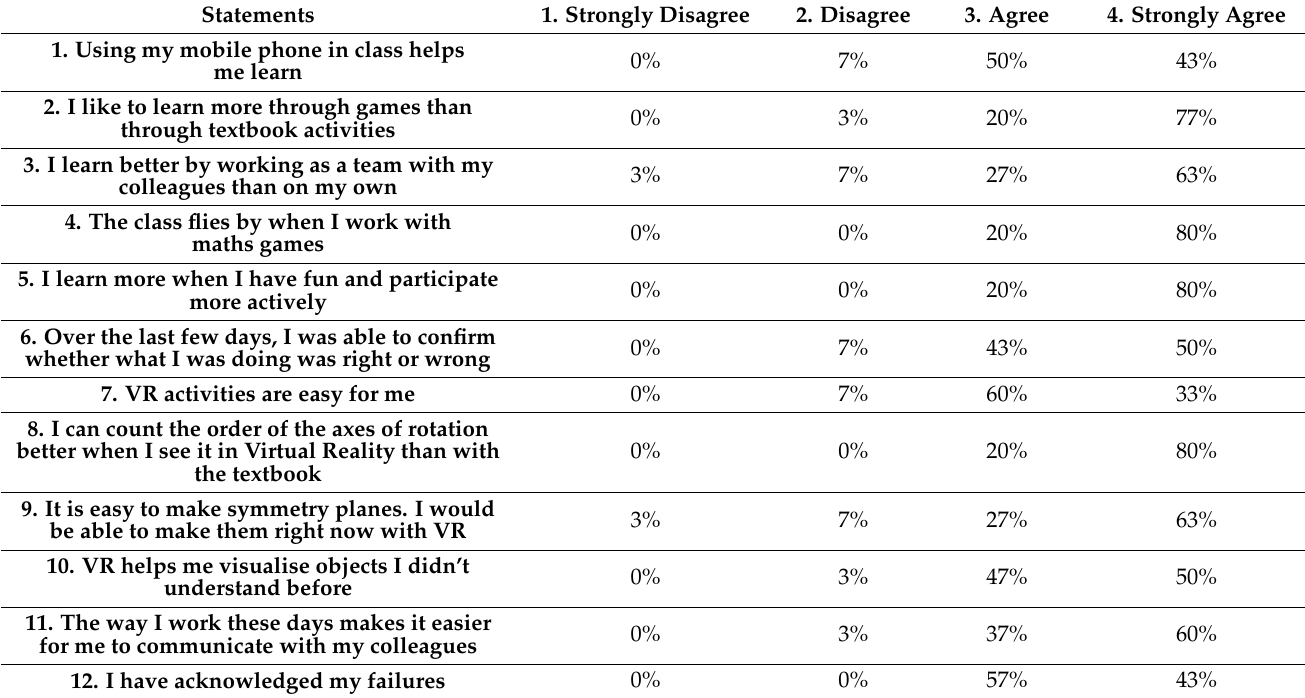
Table 8. Questionnaire